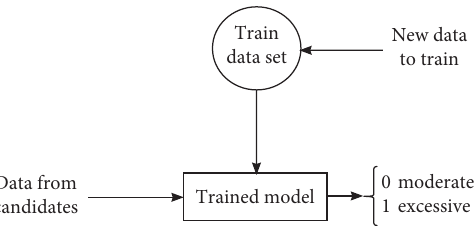
Figure 9: Usage of the DNN-based model for absenteeism pre- diction in real